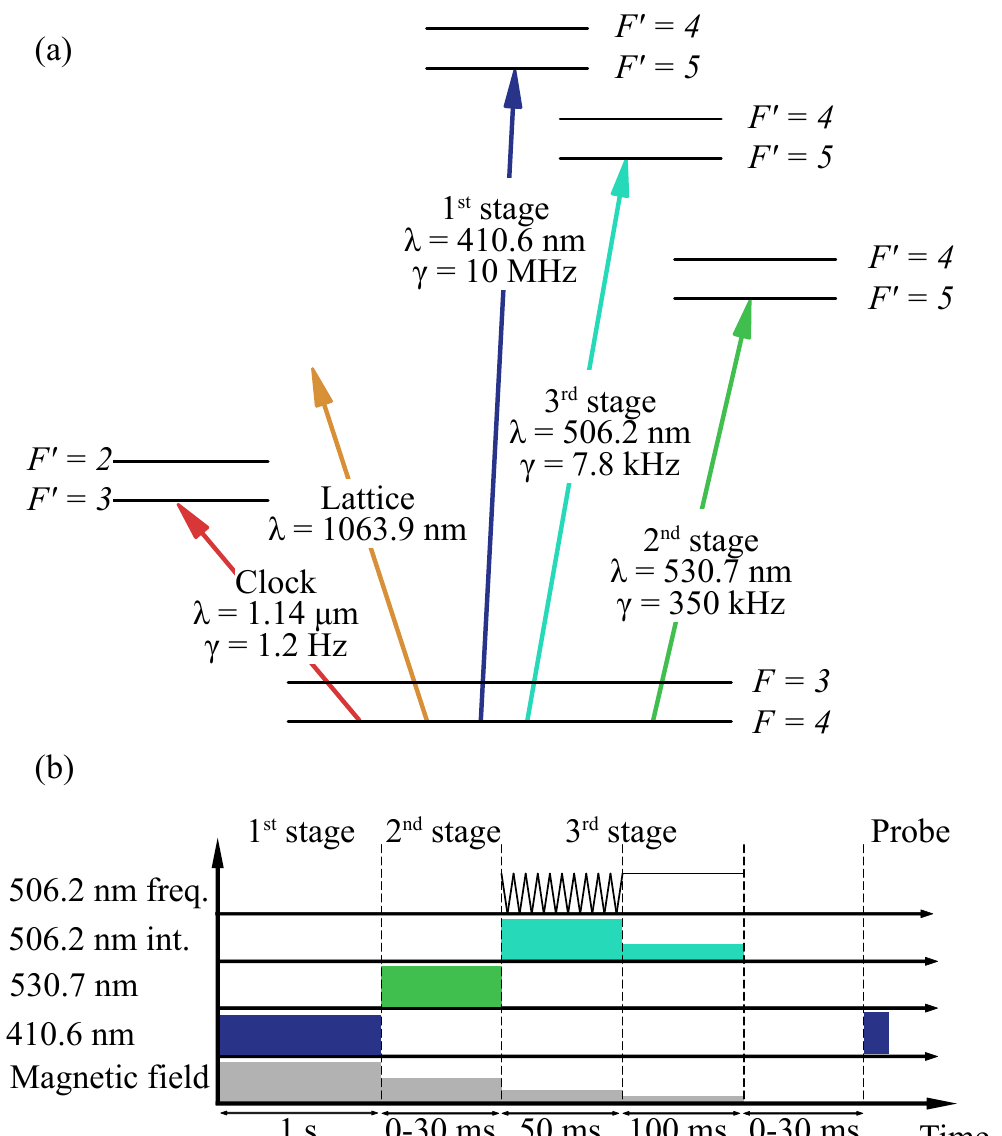
Figure 1. ( a ) The diagram of levels and transitions in Tm that we used in this work. For the 1st-stage cooling and the probe beam we use the radiation at the wavelength of 410.6nm. For the 2nd-stage cooling—530.7nm, and the 3rd-stage cooling—506.2nm, the transition that we study in this work. The radiation at 1063.9nm used to form the optical lattice and the clock transition at 1.14µm used to confirm the low temperatures, achieved in experiment. ( b ) The typical pulse sequence and its timings used in our experiments. The diagram shows the order of laser cooling pulses and the magnetic field changes with time. For 3rd stage cooling pulse the frequency and the intensity of cooling radiation showed